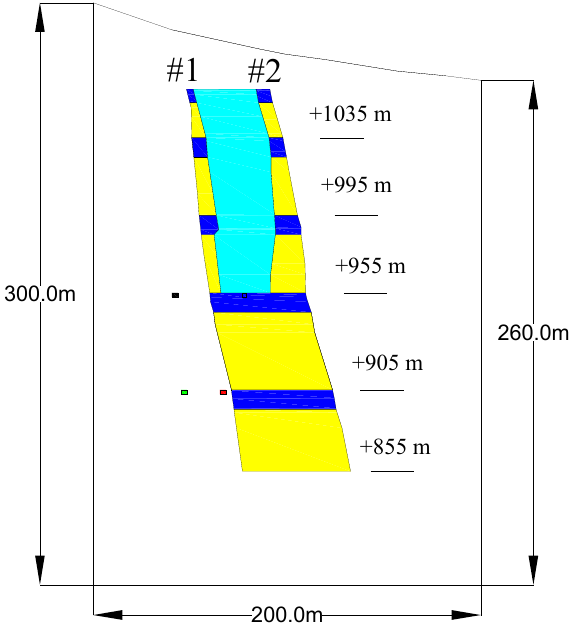
Figure 4. The diagram of mechanics model: +855 m, +905 m, +955 m, +995 m and +1035 m means the different sublevels; #1 represents the #1 ore body; #2 represents the #2 ore body;